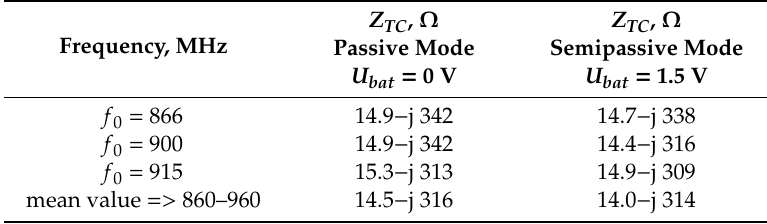
Table 2. Measuring results of impedance for passive/semipassive SL900A chip.